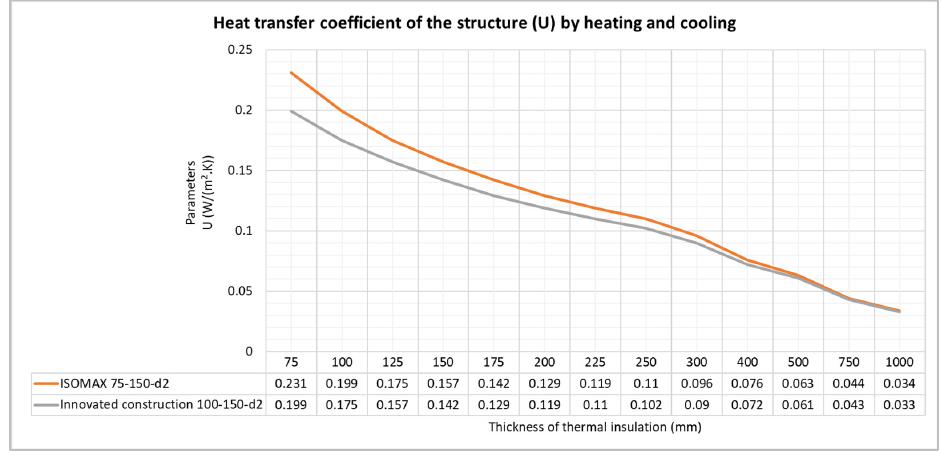
Figure 21. Dependence of the heat transfer coefficient U of the ISOMAX panel and the innovative panel on the thickness of the external thermal insulation.